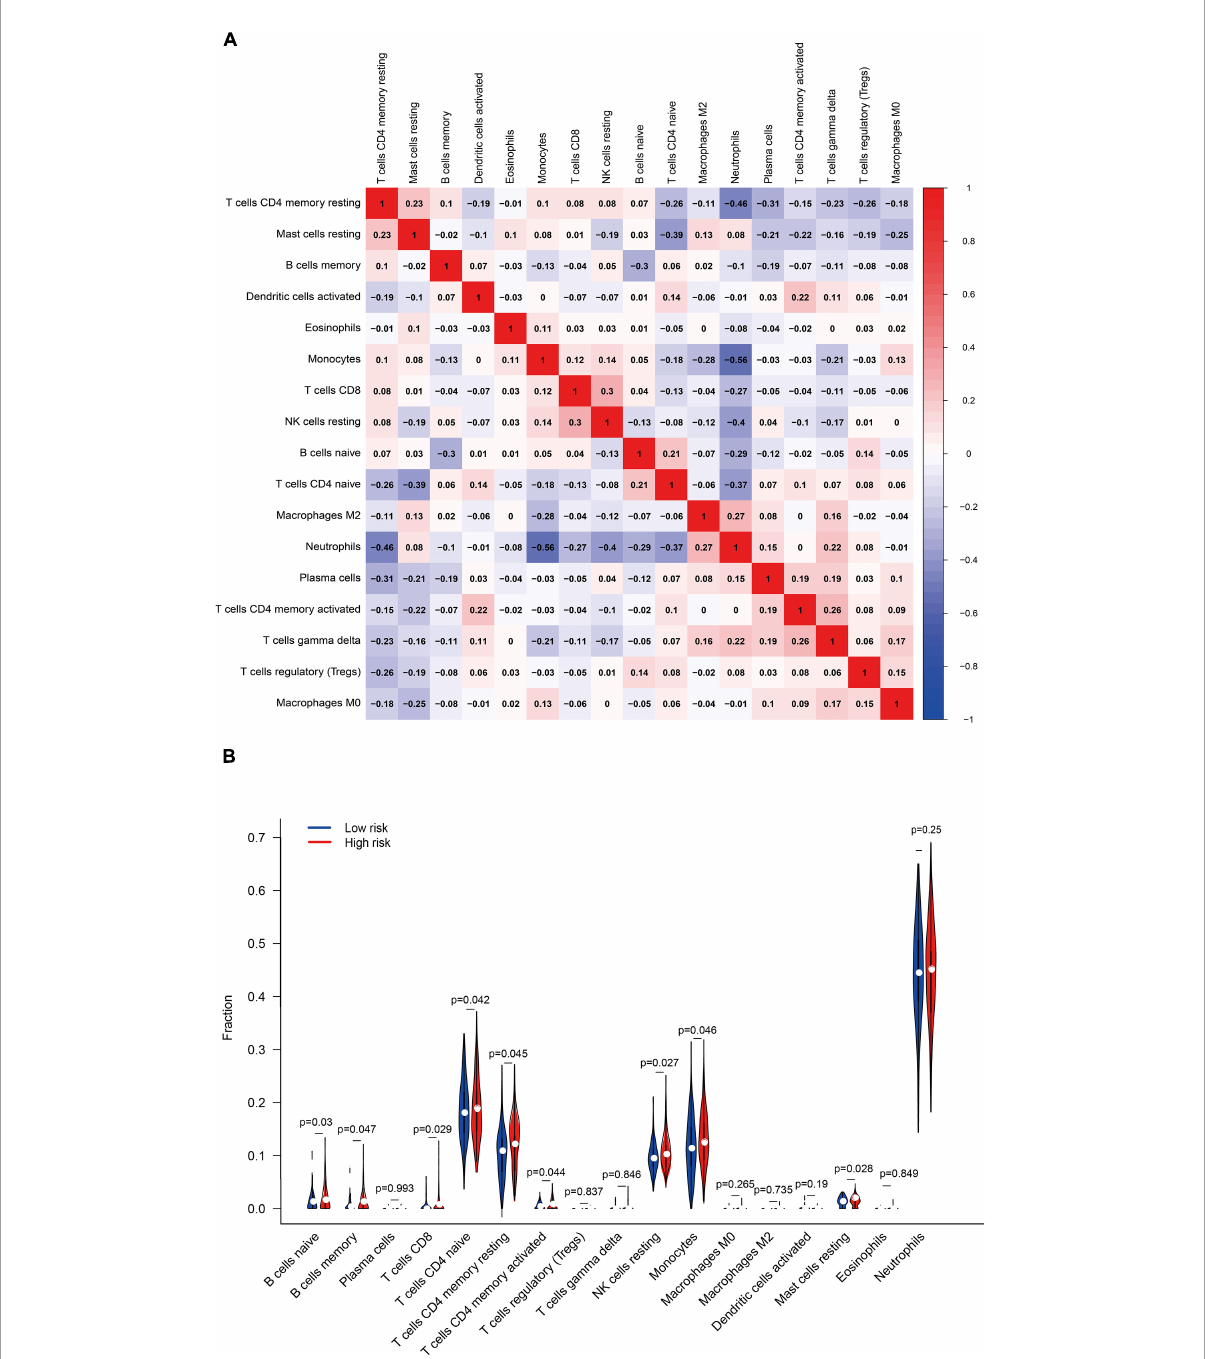
FIGURE13 (A) Pearson correlation coefficient revealed the correlation between 17 immune cells. (B) The differential expression of immune cells in the high- and low-risk groups.